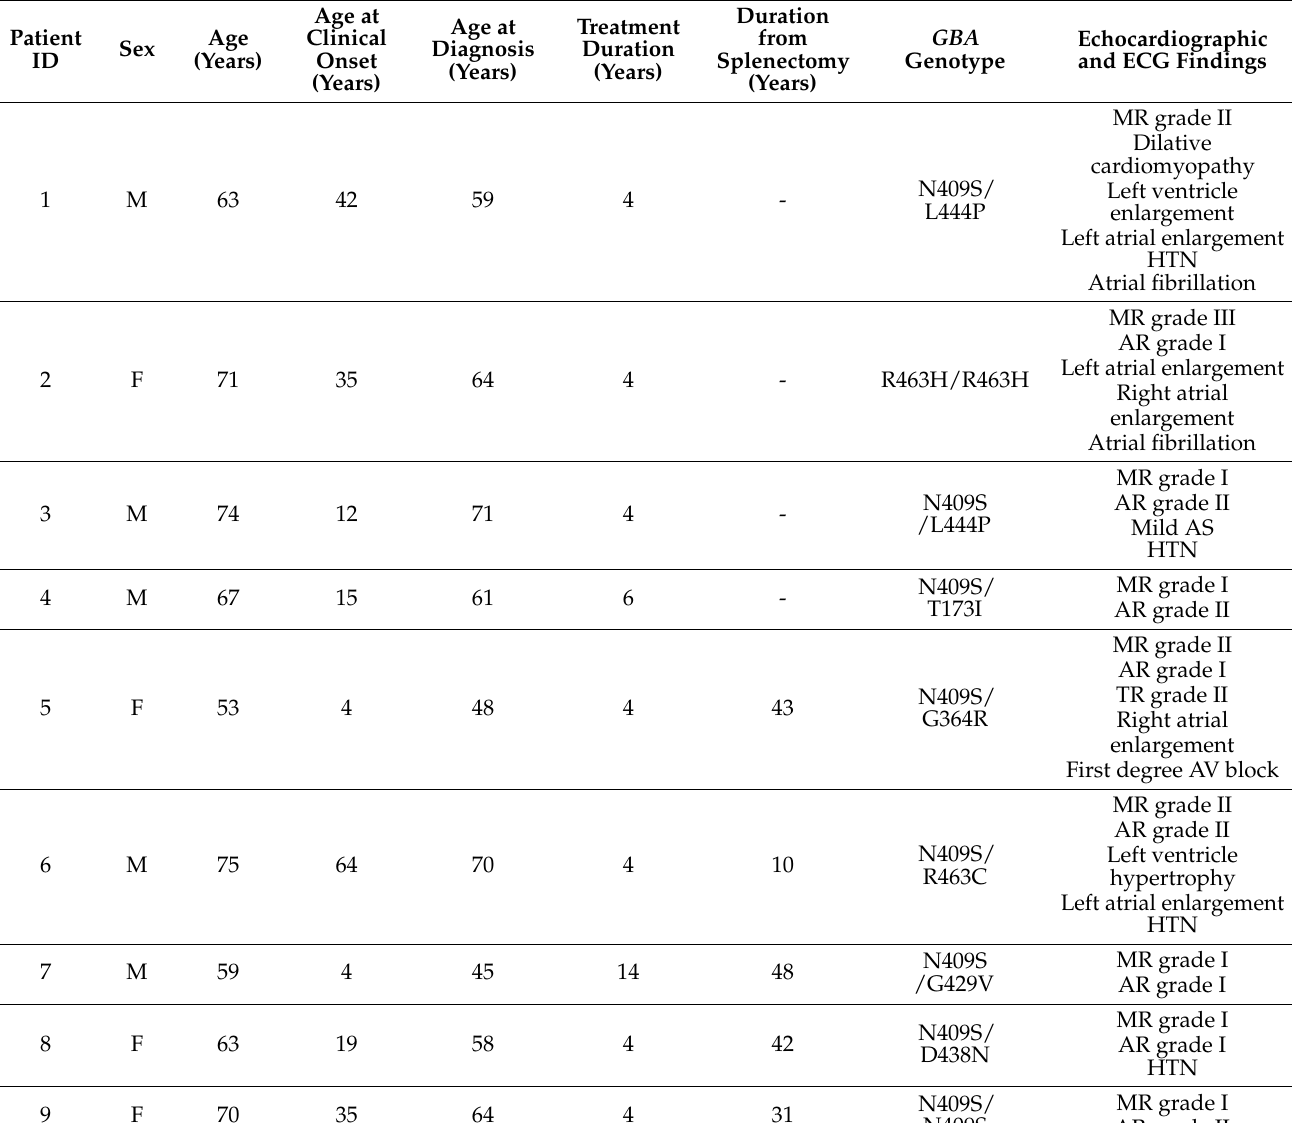
Table 2. Clinical characteristics and cardiac findings of patients with Gaucher disease type 1 and